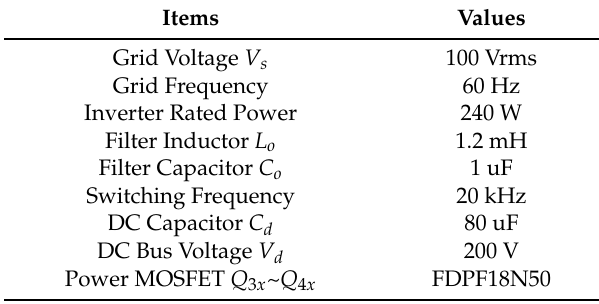
Table 1. Parameters of grid-connected inverter.